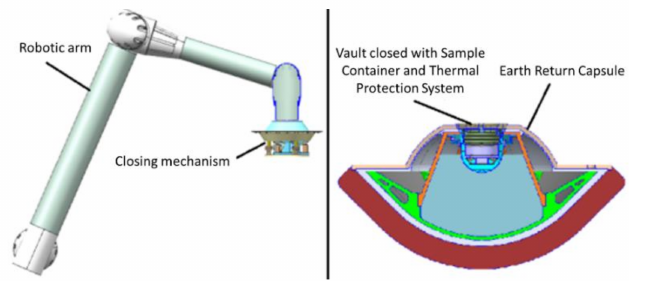
Figure 4. Sample return configuration after the closing operation (image courtesy: Airbus Defence and Space UK).